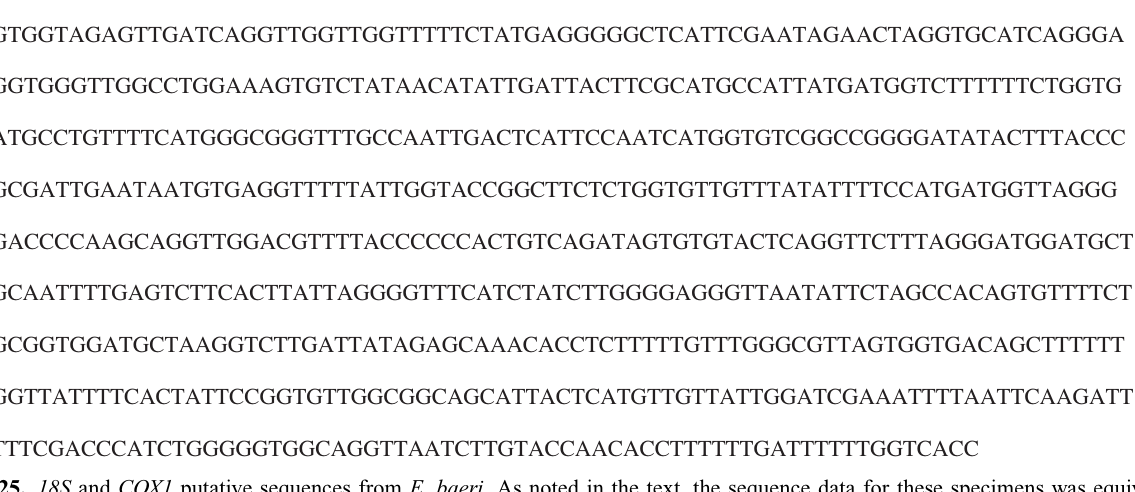
Figure 25. 18S and COX1 putative sequences from E. baeri . As noted in the text, the sequence data for these specimens was